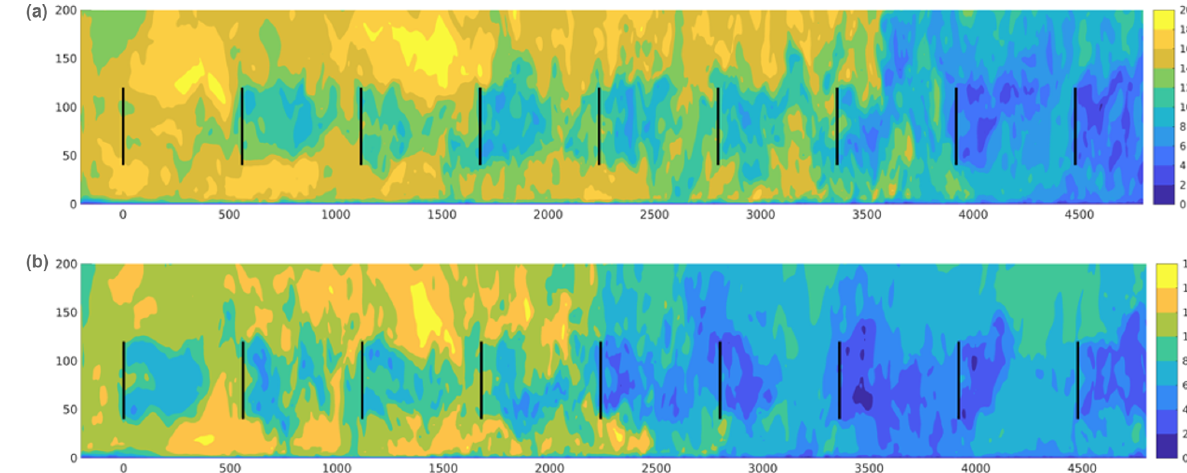
Figure 13. Cross section of wind fields from LES, taken along turbine center ( y = 0): cases 6 (a) and 7 (b) , shown at the same time after start. Vertical axis is height above the surface [m], horizontal axis is streamwise position [m], and flow travels from left to right. Black lines indicate turbine rotor positions, and color is streamwise wind velocity component in meters per second.